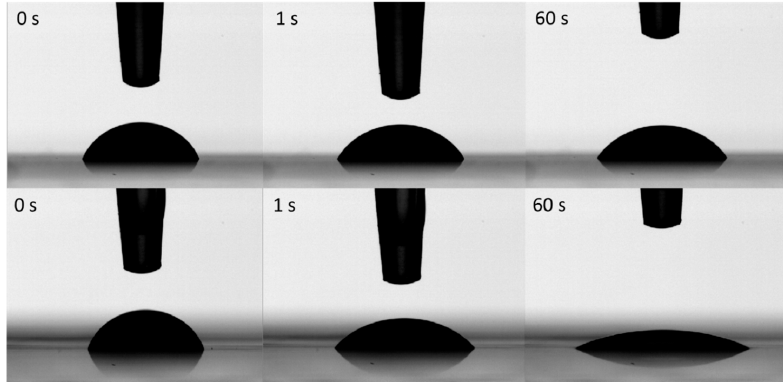
Figure 6. Contact angle of MSN–PEI (c = 5 mg/mL) on transparency (up) and HPMC (down) at 0, 1 and 60